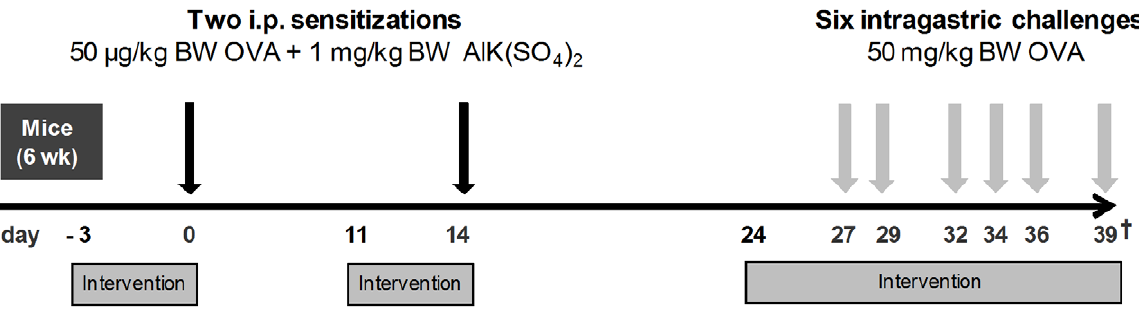
Figure 5. Experimental set up for OVA-induced allergic diarrhea. Intervention corresponds to either intragastric N. sativa or thymoquinone (with or without sub-cutaneous OR-antagonist pre-treatment) or subcutaneous OR-agonists (with or without sub-cutaneous OR-antagonist pre- treatment). (Abbreviations: i.p.=intraperitoneal, OR=opioid receptor, OVA=ovalbumin, BW=body weight, { =sacrifice).